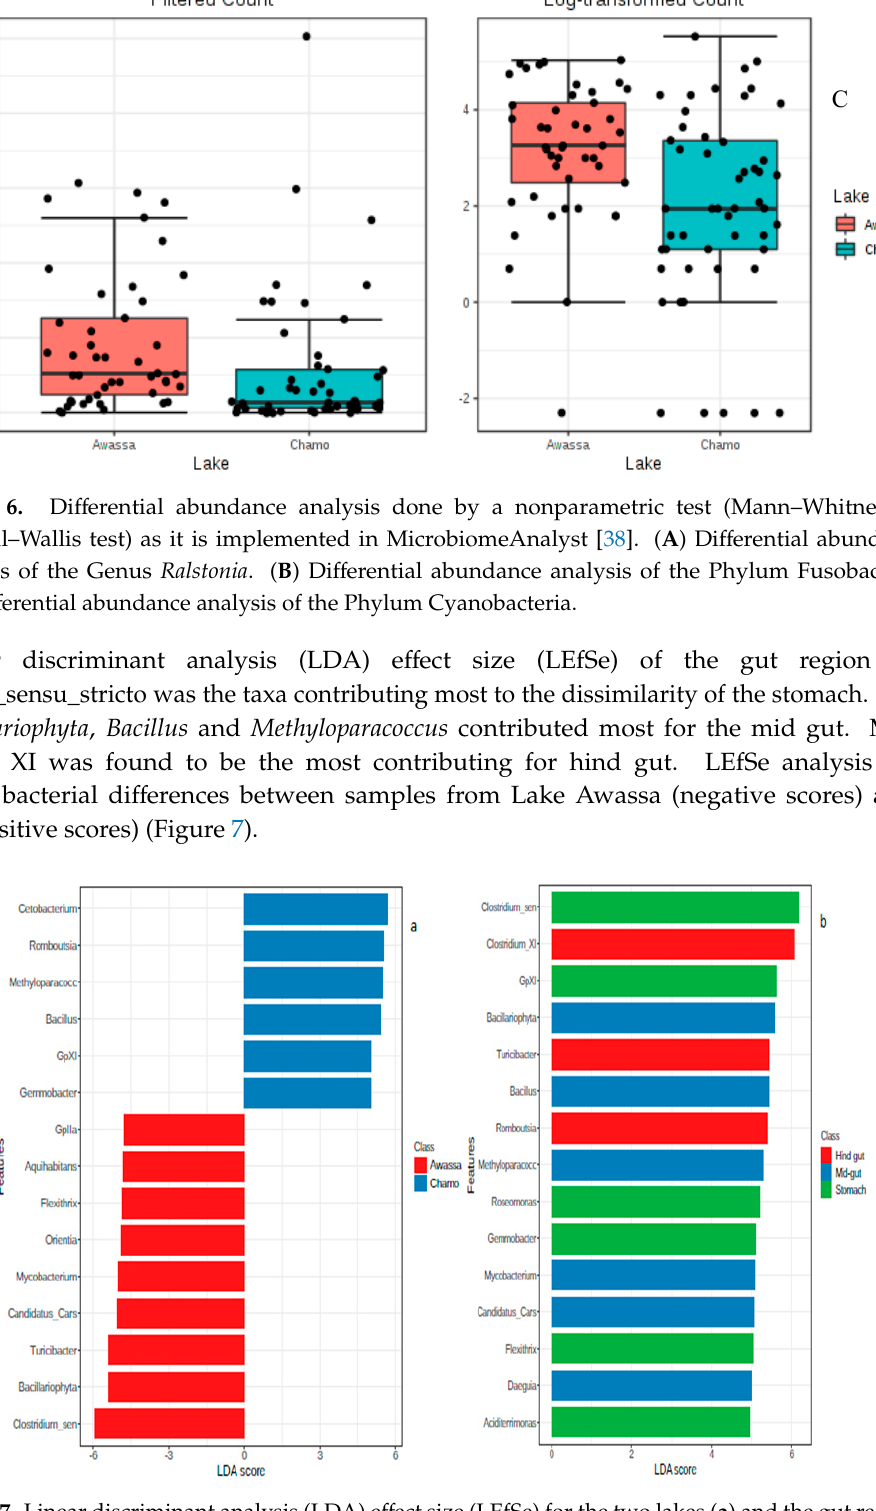
Figure 7. Linear discriminant analysis (LDA) effect size (LEfSe) for the two lakes ( a ) and the gut regions ( b ). Horizontal bars represent the effect size for each taxon.